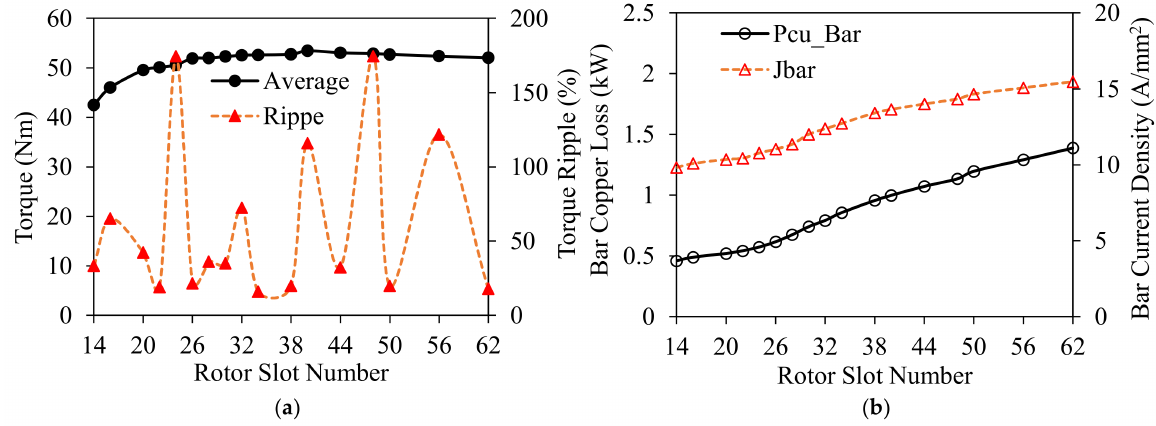
Figure 24. Influence of the rotor slot number on the performance characteristics of 24S/8P AIM: ( a ) torque and torque ripple and ( b ) bar copper loss and bar current density.